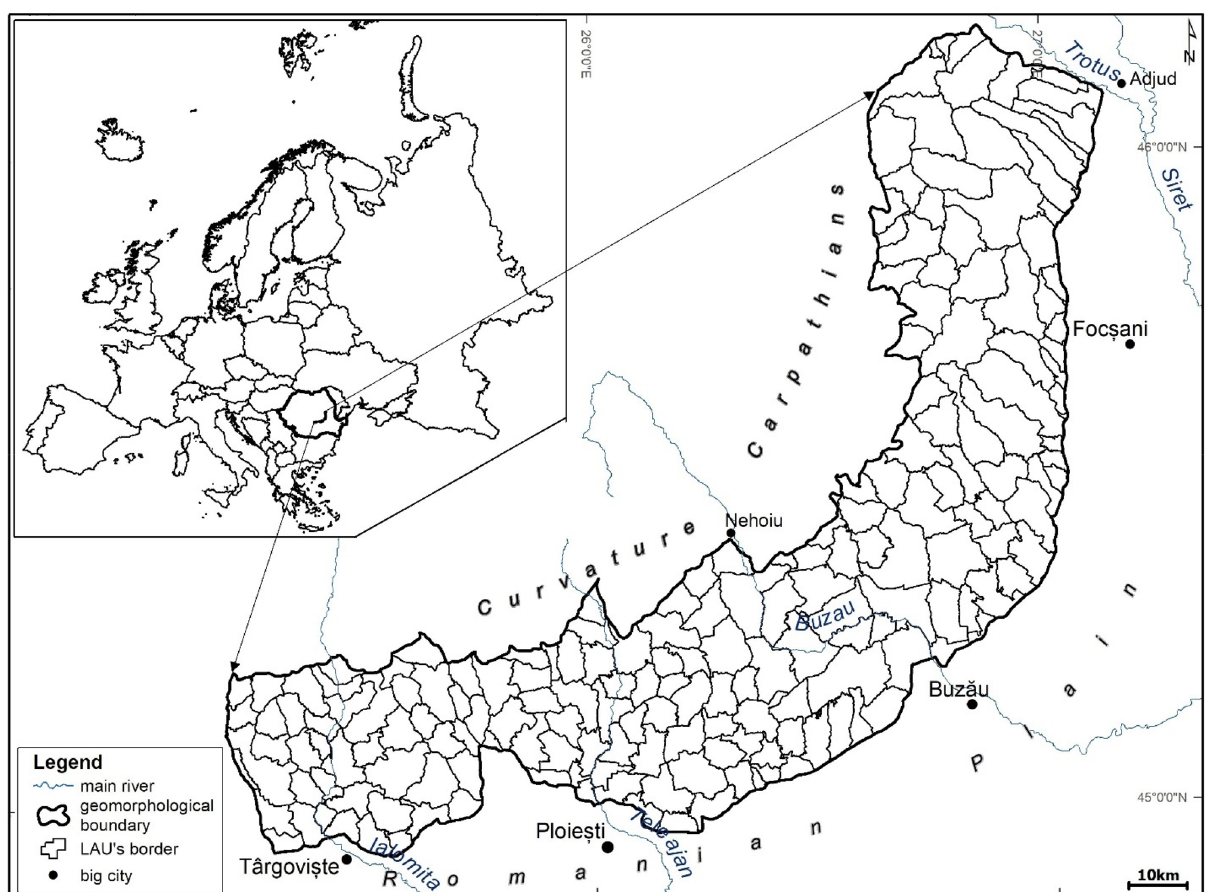
Figure 1. The location of Curvature Subcarpathians and the border of Local Administrative Units level 2. The geographic data vector comes from the https:// geo- spati al. org; map created by G. Minea using ArcGIS Pro version 2.8.6, https:// pro. arcgis. com/ en/ pro- app/2. 8/ get- start ed/ get- start ed.